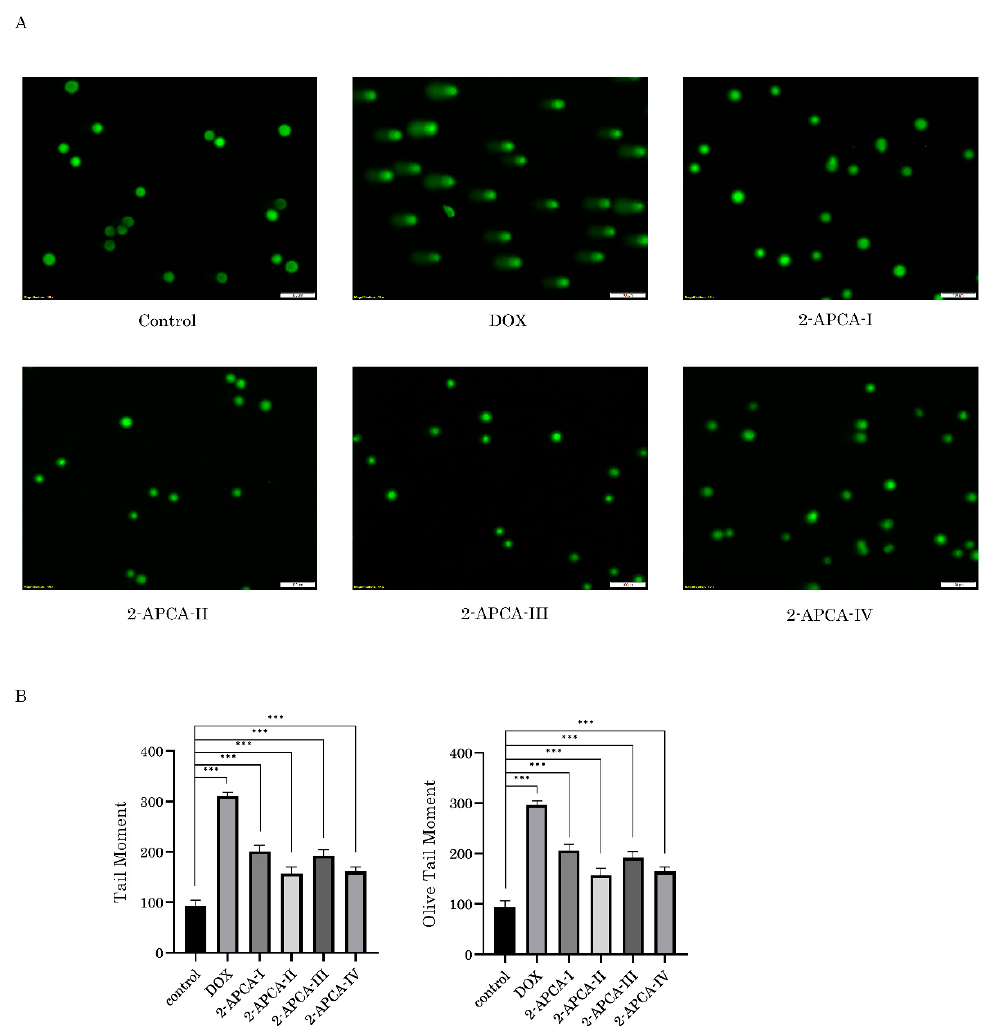
Table 4. The amino acid composition of the 2-APCAs binding sites in tubulin.